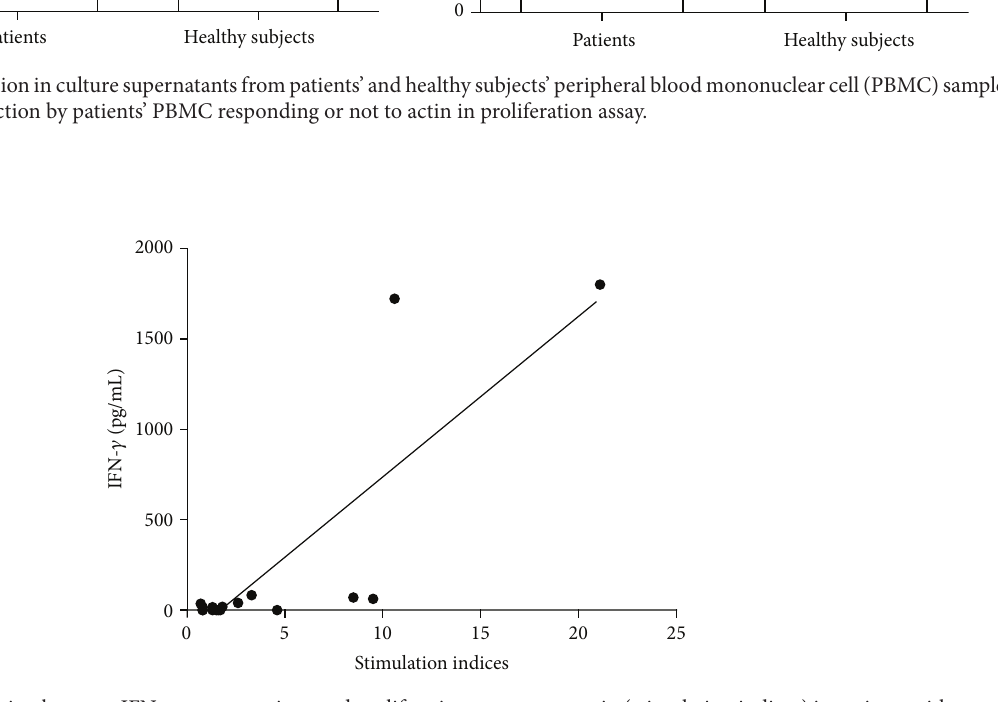
Figure 4: Positive correlation between IFN- 𝛾 concentrations and proliferative response to actin (stimulation indices) in patients with carotid atherosclerosis. 𝑃 < 10 −4 ; 𝑟 = 0.71